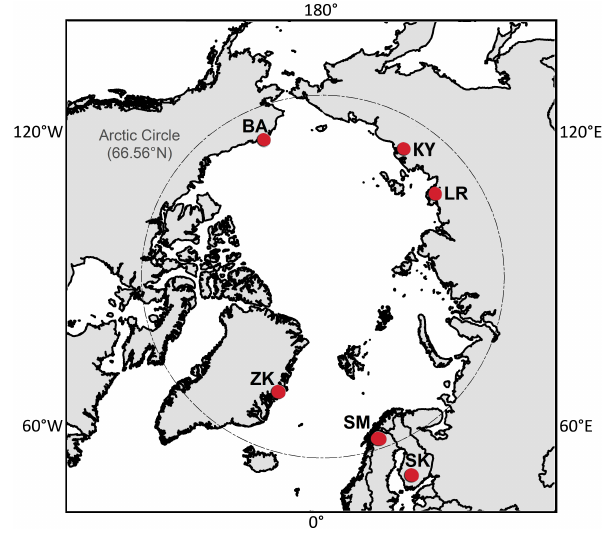
Fig. 1. Locations of the flux tower sites (circles) used in this study, including Barrow (BA), Kytalyk (KY), Lena River (LR), Siikaneva (SK), Stordalen Mire (SM) and Zackenberg (ZK). The Arctic Circle is indicated by the dashed